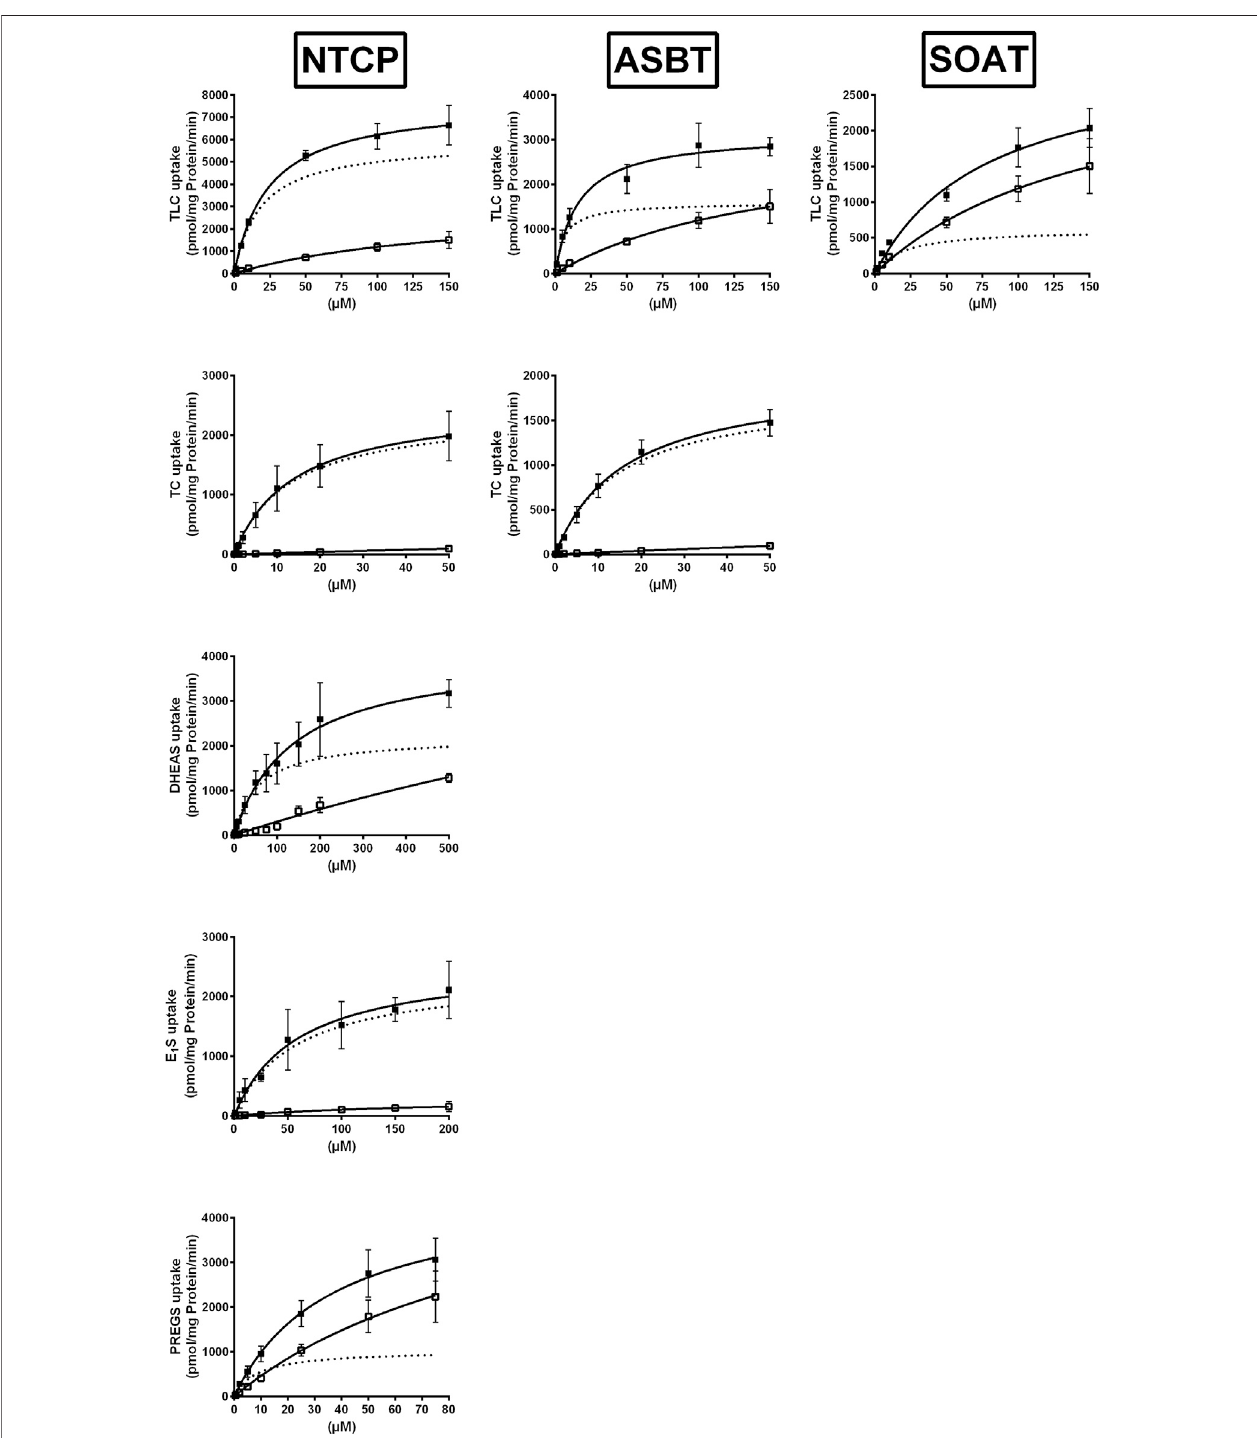
FIGURE 2 | NTCP, ASBT, and SOAT transport kinetics. Concentration-dependent uptake was analyzed in NTCP-HEK293, ASBT-HEK293, and SOAT-HEK293 cells for the indicated substrates at increasing substrate concentrations. Stably transfected HEK293 cells were pretreated with 1 μ g/ml tetracycline to induce carrier expression. HEK293-FlpIn cells were used as control. Uptake was analyzed for 1 min at 37 ° C. Afterward, the medium was removed and each cell monolayer was washedandprocessedtodeterminetheproteincontentandcell-associatedradioactivity.Speci fi cuptakewascalculatedbysubtractingnon-speci fi cuptakeofthe HEK293-FlpIn control cells (open squares) from uptake into carrier-overexpressing HEK293 cells ( fi lled squares) and is shown by broken lines. The values represent means ± SD of duplicate experiments, each with triplicate determinations ( n (cid:1) 6). Transport kinetic parameters are summarized in Table 2 .